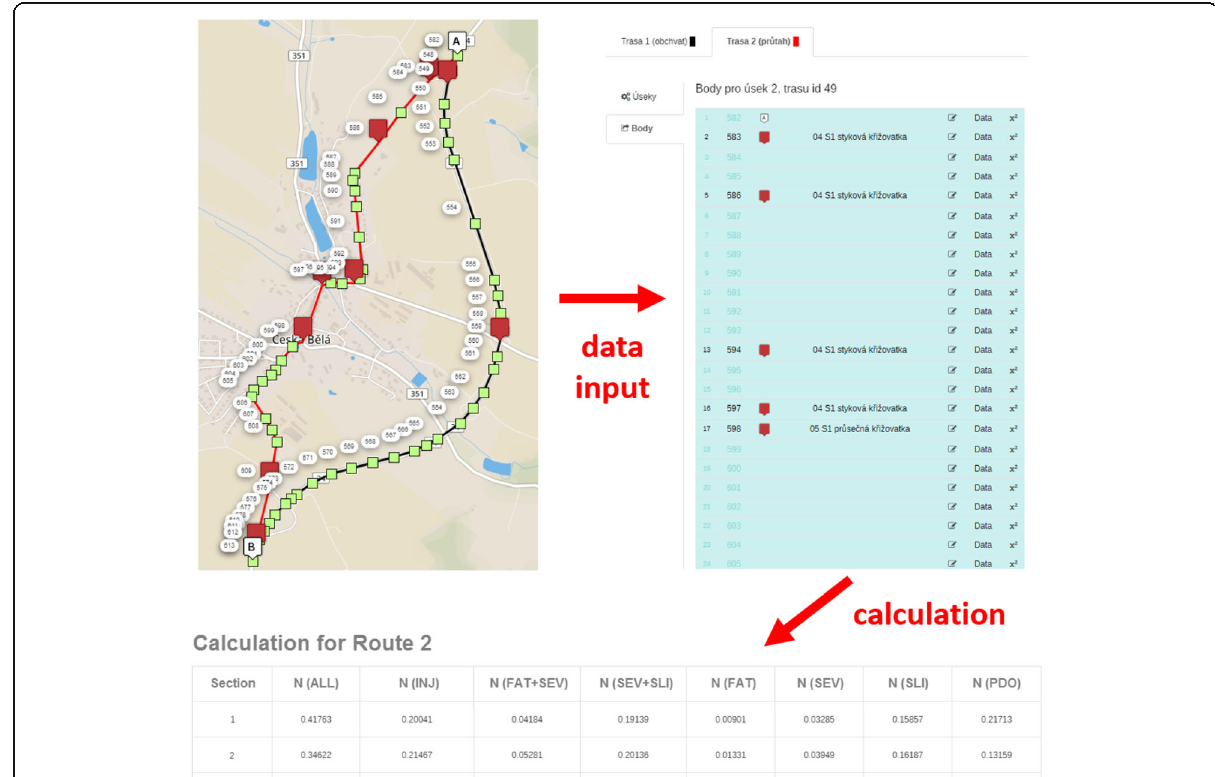
Fig. 1 Illustration of a principle of the developed on-line road safety impact assessment